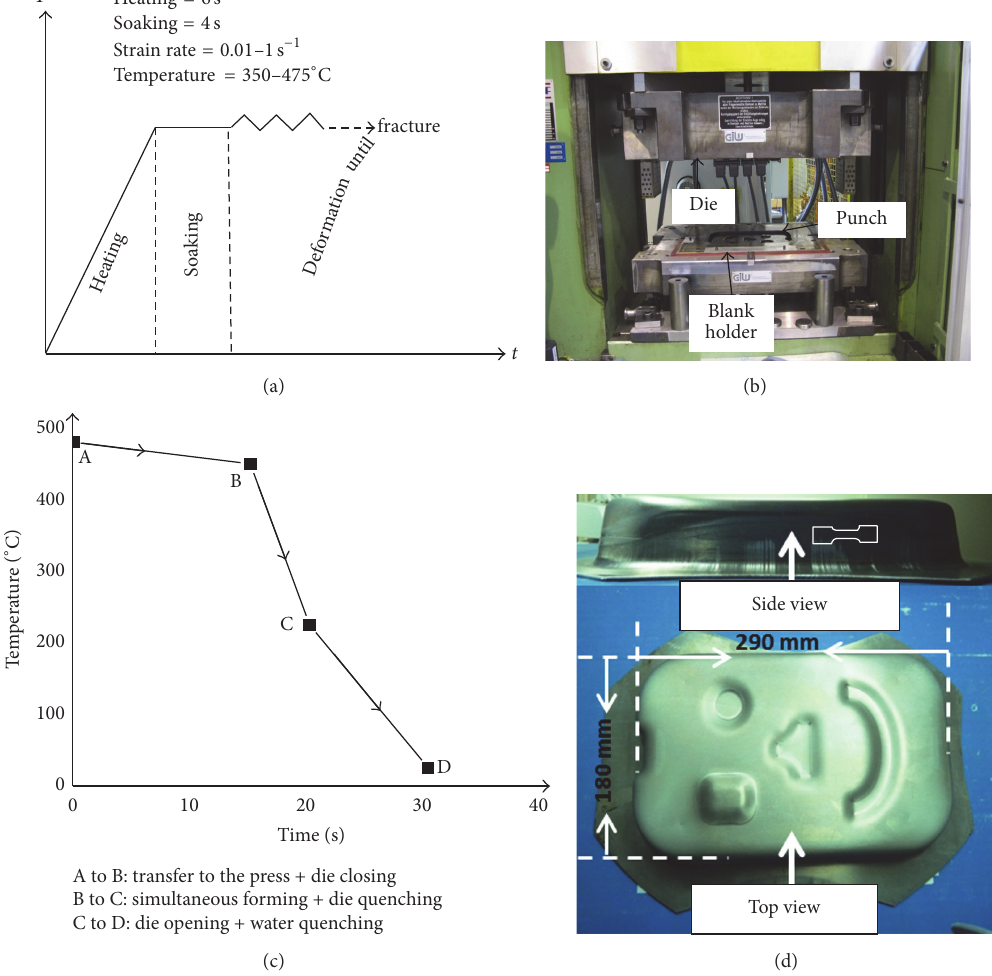
Figure 2: (a) Schematic of the tension tests procedure. (b) Hydraulic press with smiley form die, (c) schematic diagram showing a typical thermomechanical history for the deep drawing process, and (d) the smiley form prototype after deep drawing. The location from where samples were taken is also shown in (d).